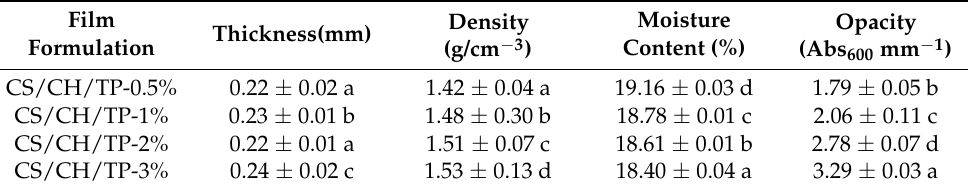
Table 1. Density, Moisture Content and Opacity of the Chitosan/Corn Starch/Tea Polyphenol Films with Different TP